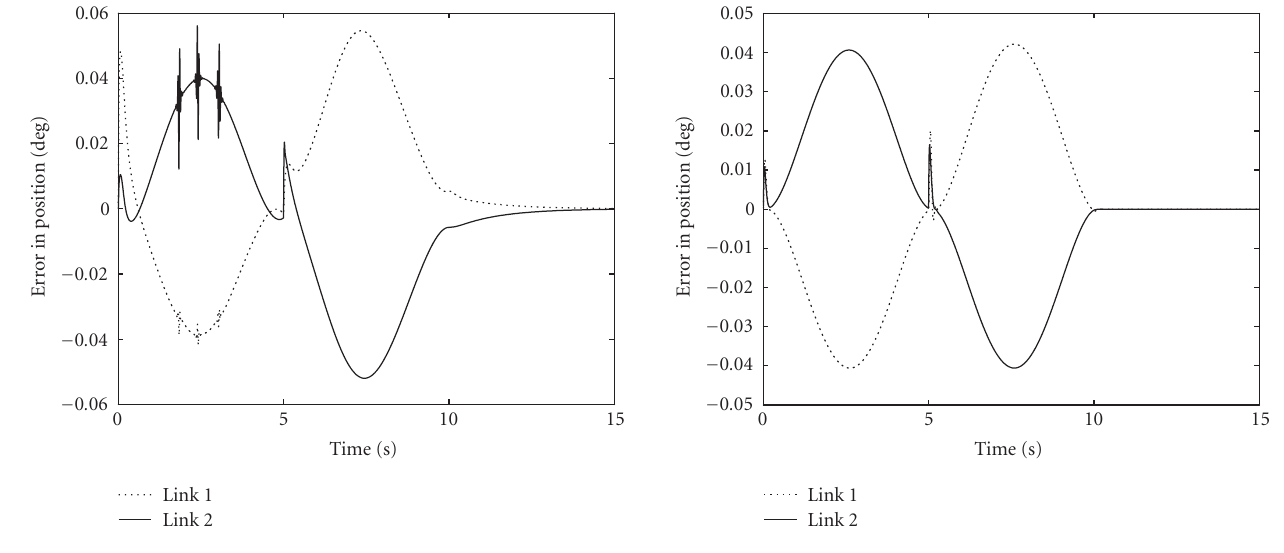
Figure 10: Errors for ACDIDC, trajectory 1.